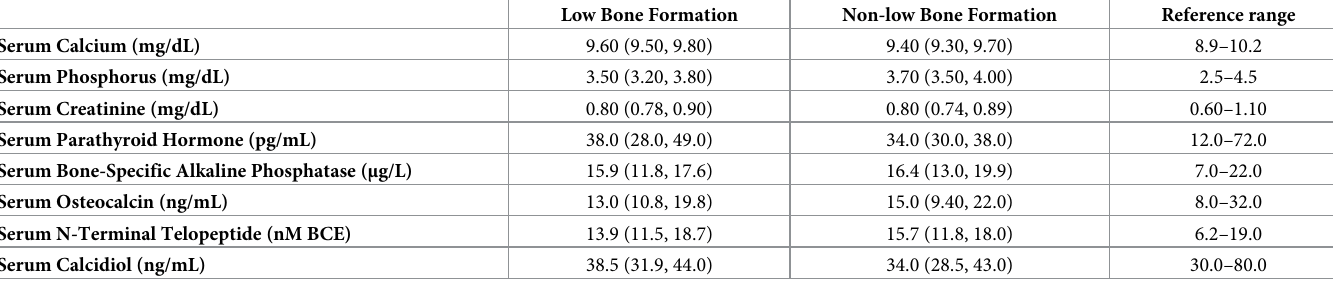
Table 2. Serum biochemical parameters of patients with different bone formation rates in trabecular bone.